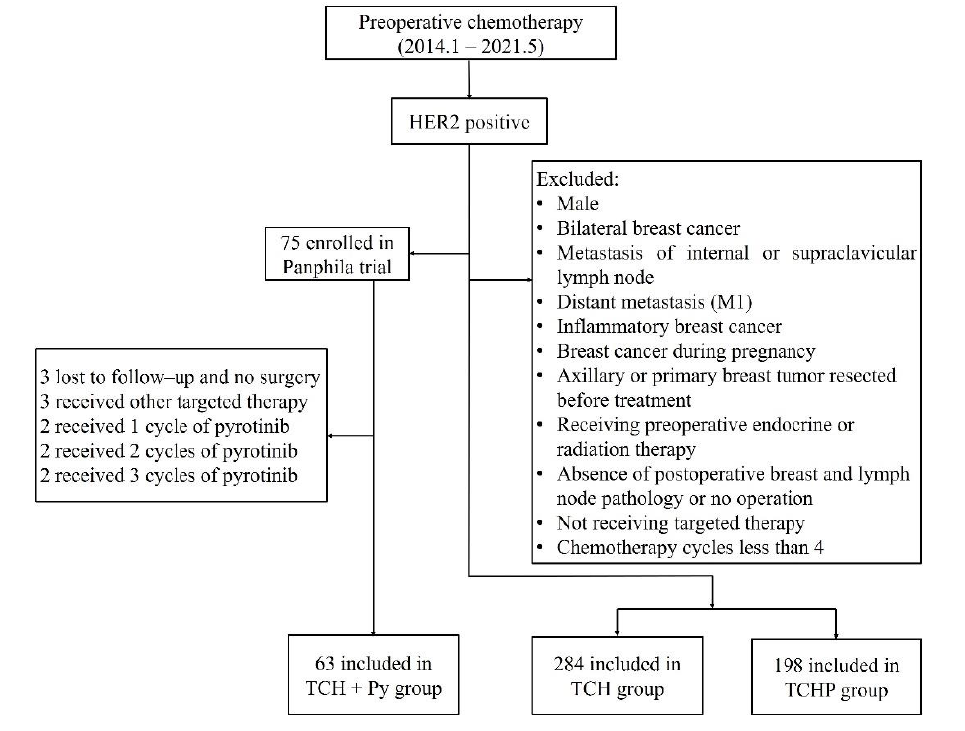
Figure 1. Patient flow diagram. Table 1. Characteristics of patients in three cohorts.